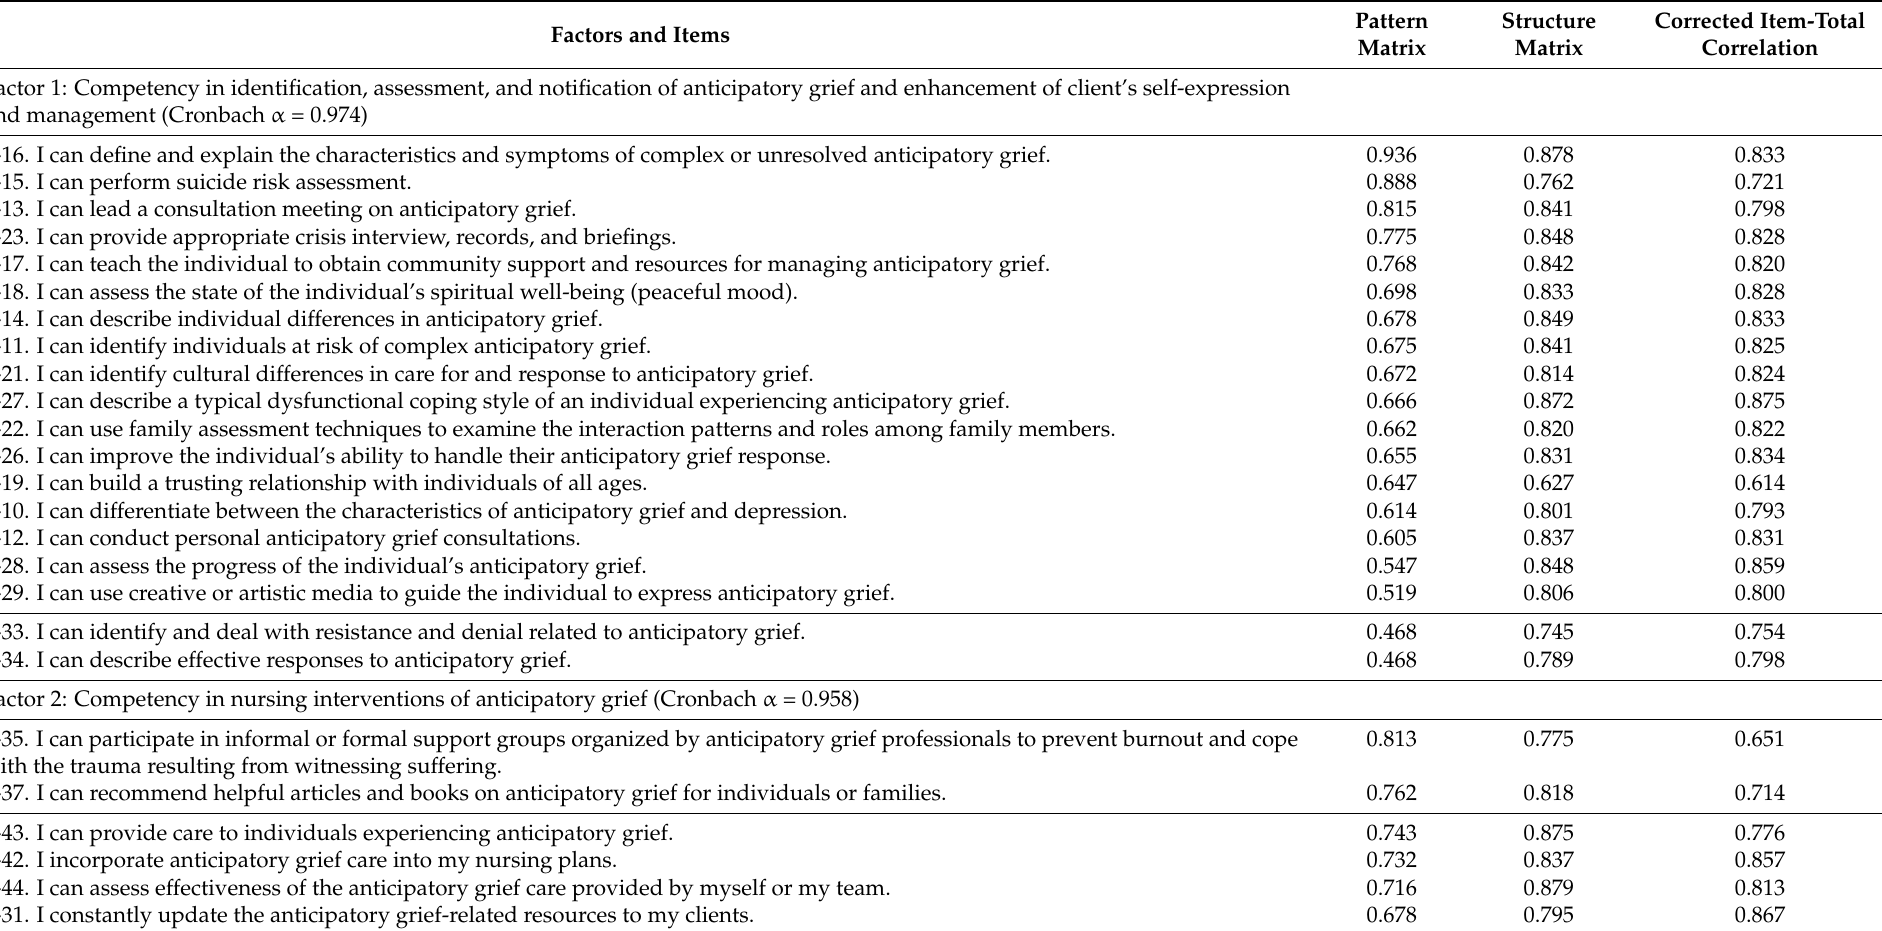
Table A1. Results of exploratory factor analysis using principal component analysis with Promax rotation (n = 251).